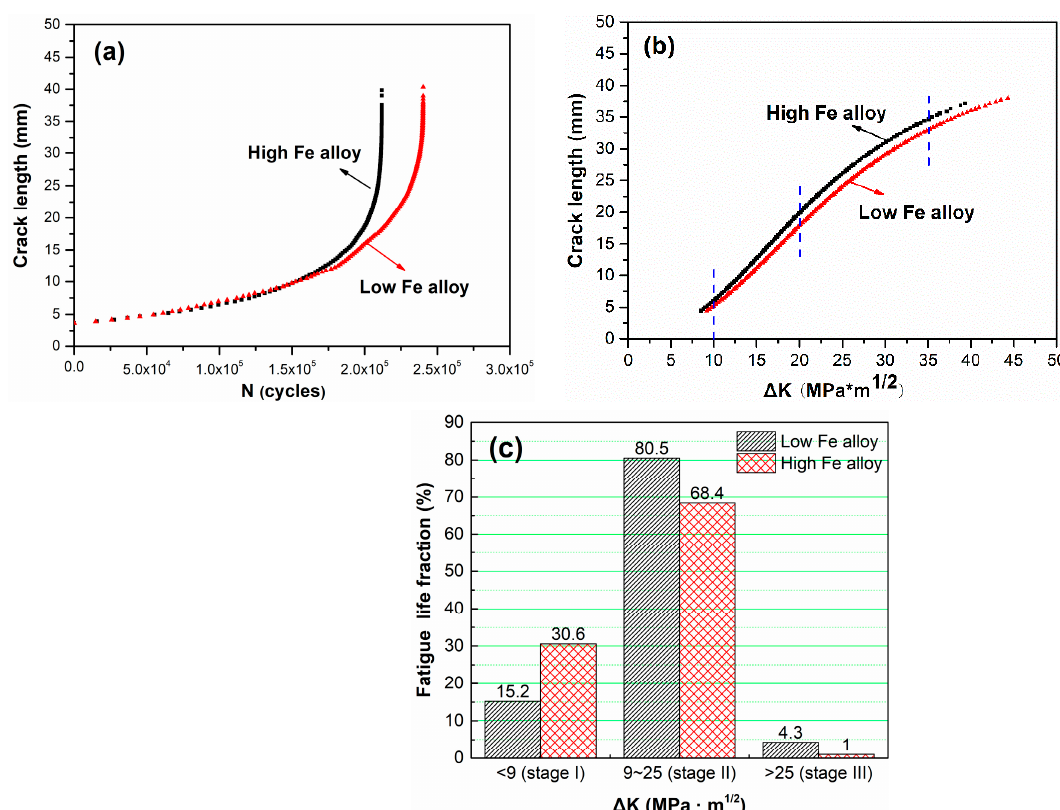
Figure 5. ( a ) Fatigue crack length versus number of cycle curves, ( b ) fatigue crack length versus Δ K curves, and ( c ) fatigue life fraction at different stages of High Fe and Low Fe alloys.